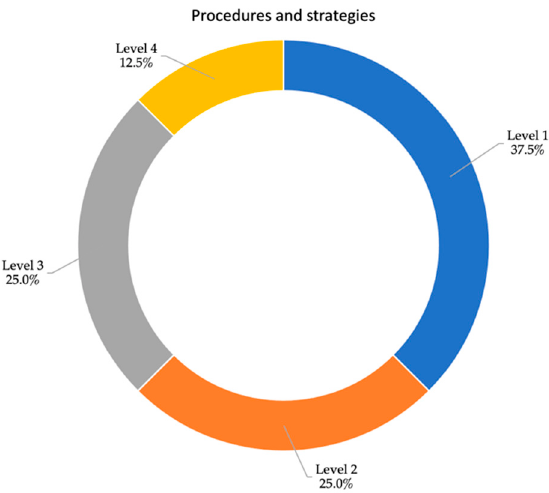
Figure 9. Procedures and strategies by level.